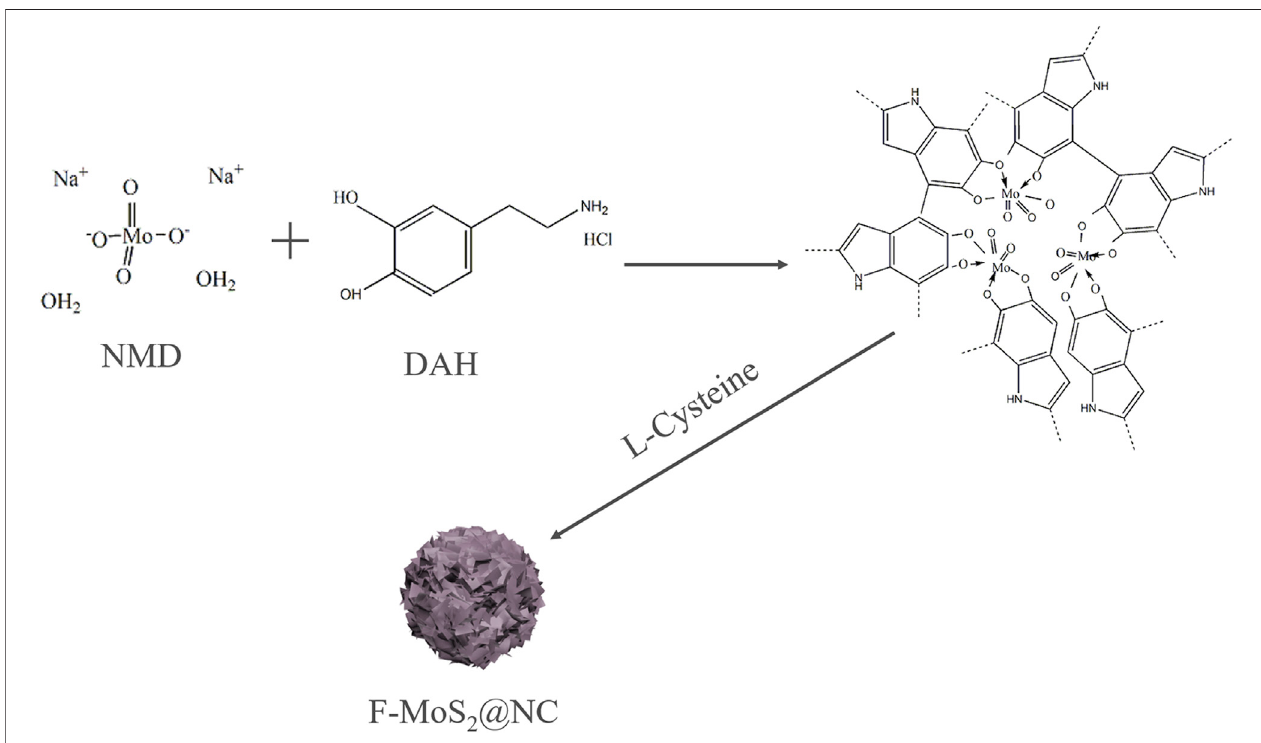
FIGURE 1 | Schematic illustration of F-MoS 2 @NC fabrication process.